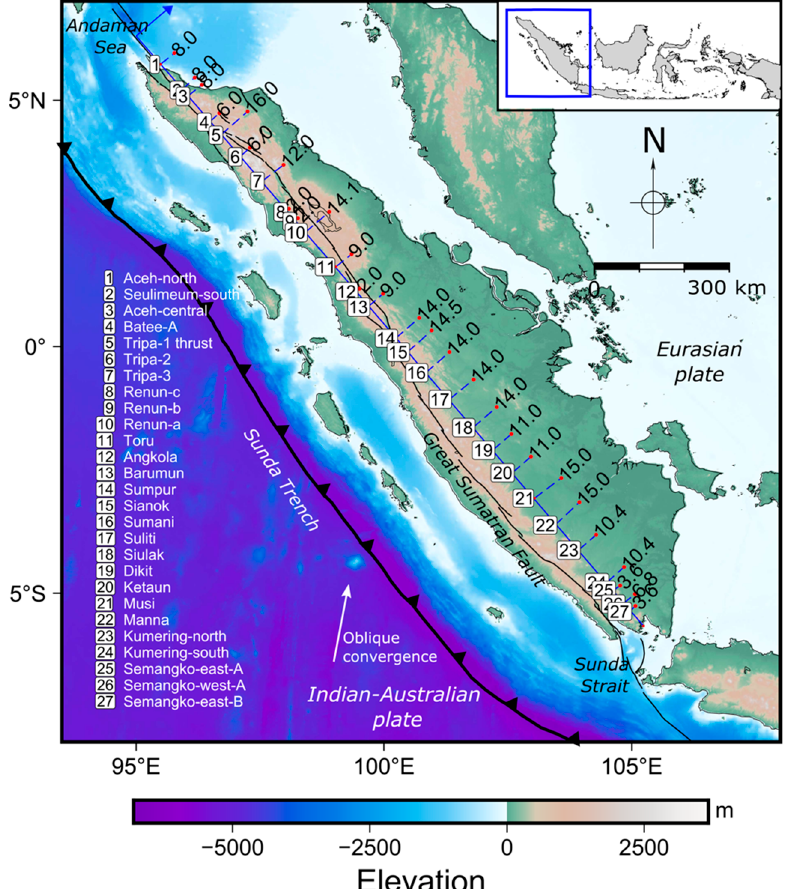
Figure 1. Slip rate (mm/year) distribution across the Great Sumatran Fault (GSF) zone at each segment of the fault. The slip rates are inferred from GPS measurements of previous studies [15,21–23]. The fault segments refer to the National Center for Earthquake Studies of Indonesia